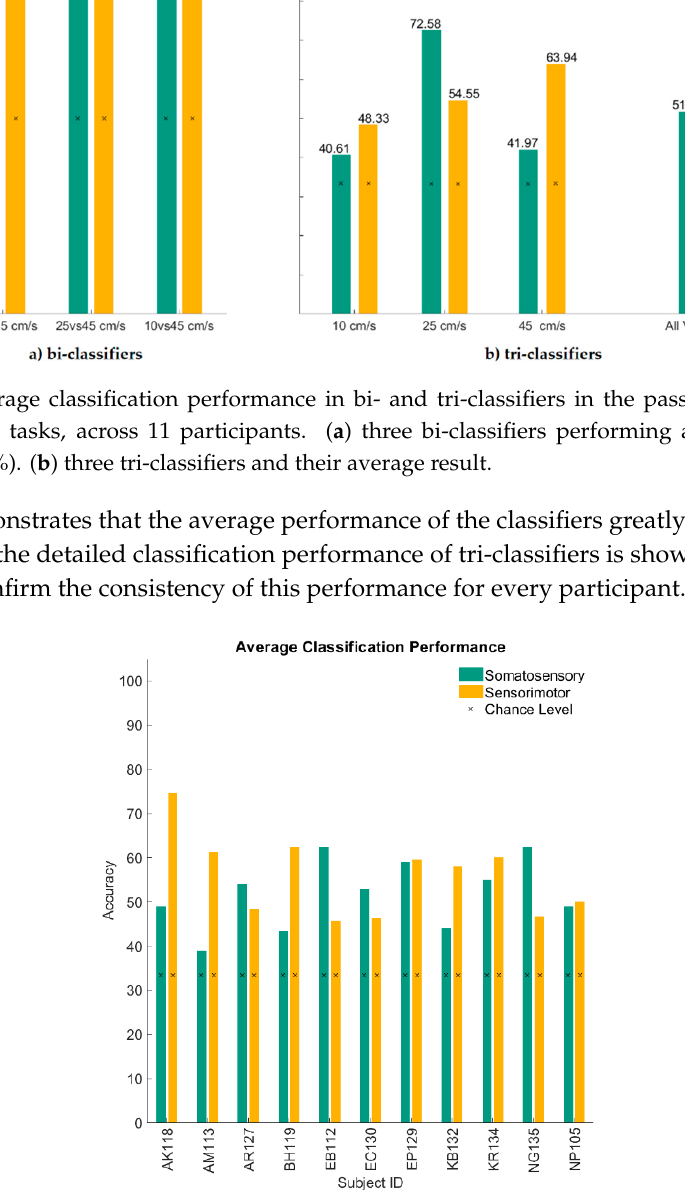
Figure 4. Average classification performance of tri-classifiers in the passive (green) and active (yellow) tasks for individual participants.